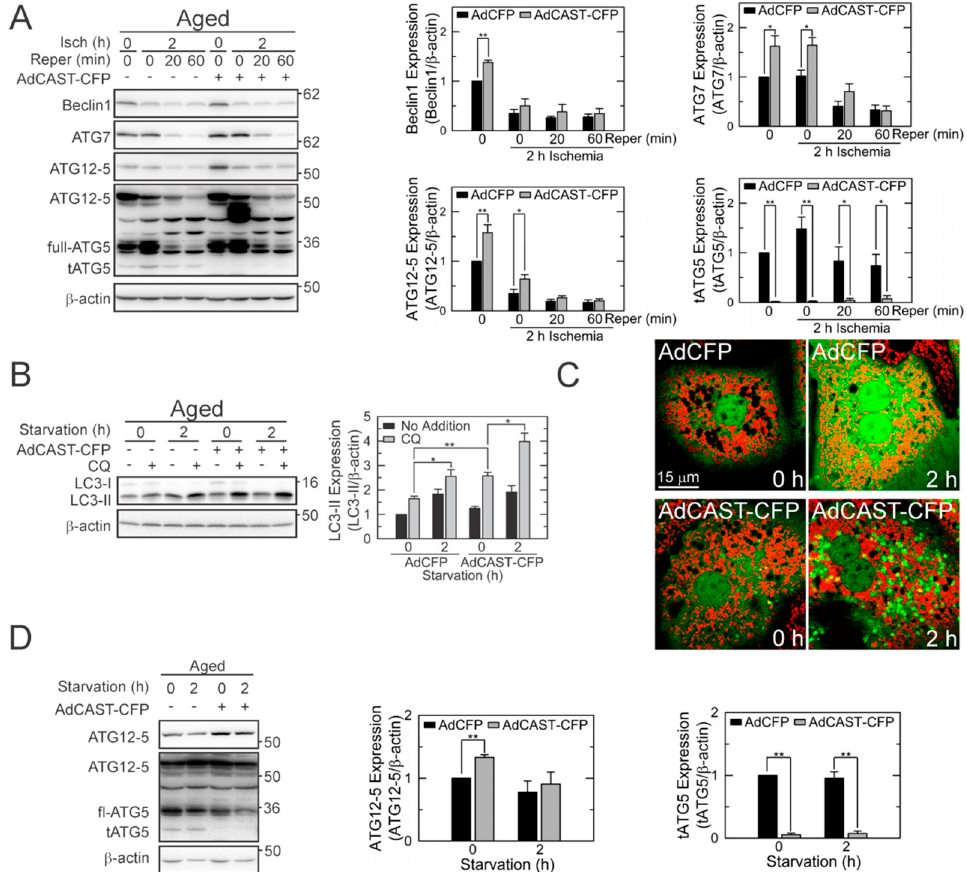
Figure 5. Suppression of tATG5 formation in reperfused aged hepatocytes by CAST overexpression. ( A ) IB analysis of ATGs during I/R of aged hepatocytes ( n = 4). Graph represents the quantification of ATGs relative to their levels at normoxia without CAST overexpression. ( B ) Effects of CAST overexpression on autophagy induction under starvation conditions ( n = 4). Changes in LC3-II were expressed relative to its level at 0 h without CAST overexpression. ( C ) Confocal images of GFP-LC3 and TMRM in aged hepatocytes after 2 h of starvation with (bottom panels) and without CAST overexpression (top panels). ( D ) IB analysis of ATGs in aged hepatocytes during 2 h of starvation ( n = 3). Changes in individual ATGs were expressed relative to their levels at 0 h without CAST overexpression. * p < 0.05 and ** p < 0.01.